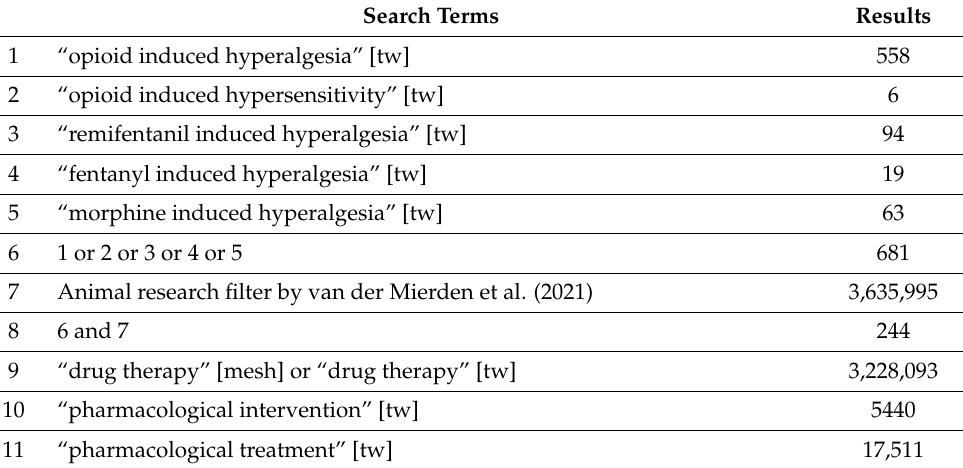
Table A4. PubMed search strategy development. The number of records retrieved for search items in